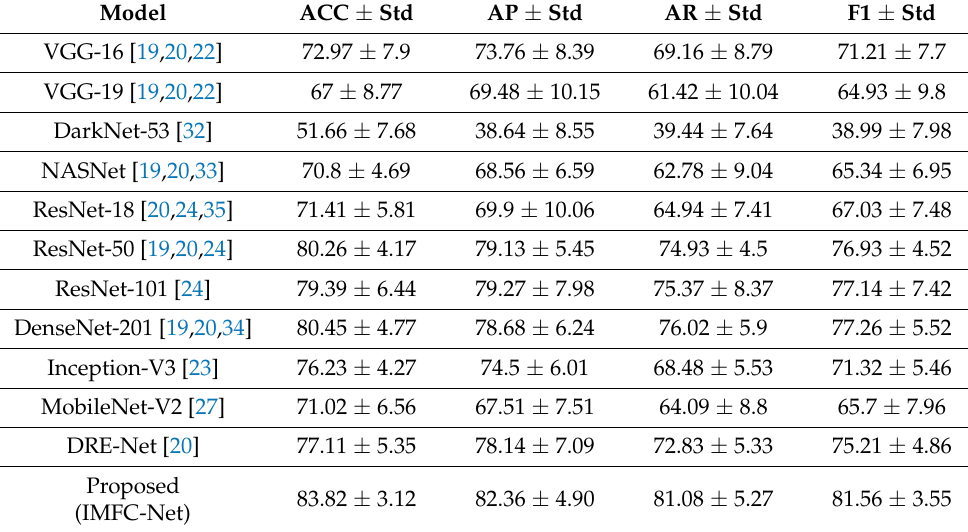
Table 5. Comparative performance analysis of the average results of ten-fold cross-validation be- tween the state-of-the-art and proposed models using random in-plane translation and rotation augmentation (online augmentation) for the shoulder implant dataset. (ACC: accuracy, AP: average precision, AR: average recall, F1: F1.score, Std: standard deviation, unit: %).